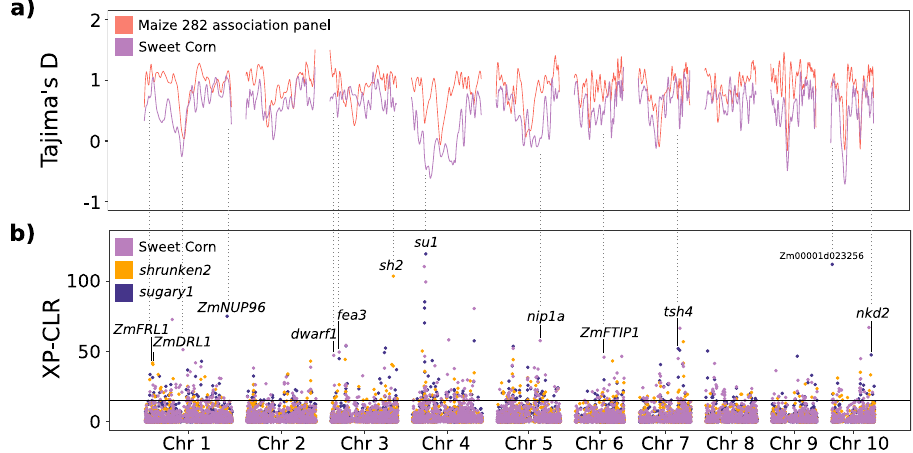
Fig. 5 Genome-wide distribution of sweet corn speci fi c selective sweeps. a Tajima ’ s D calculated on the sweet corn population and the maize 282 association panel (excluding the sweet corn lines within the maize 282 association panel). b XP-CLR estimated by comparing the maize 282 association panel against the sweet corn population (purple), the shrunken2 subpopulation (orange), and the sugary1 subpopulation (dark